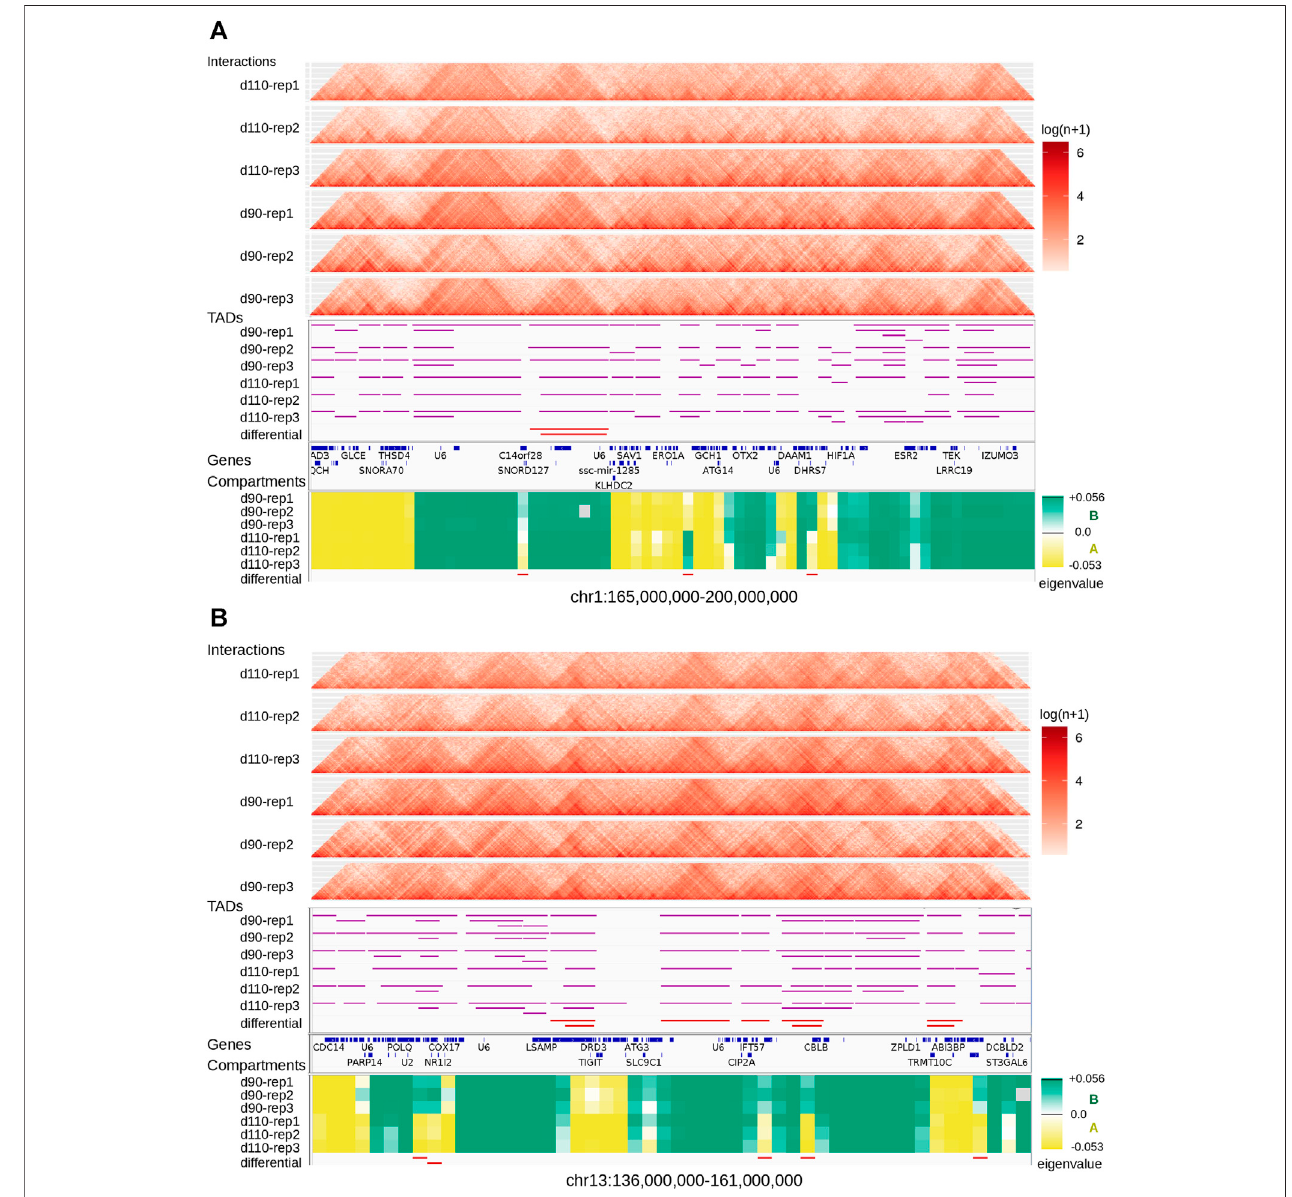
FIGURE2| Landscapeoftopologicalfeaturesinthepiggenome.Hi-Cinteractionmaps (top,heatmaps) ,TADs (middle,horizontalpurplelines) ,andgenomic compartments (bottom, green/yellow eigenvalues for A/B compartments respectively) are displayed for the six samples at two loci of the pig genome: one on chromosome 1 (A) and one on chromosome 13 (B) . Annotated genes are listed between TADs and compartments. The last track (at the bottom) shows regions with a consistent switch of compartment for all replicates (AAA → BBB or BBB →